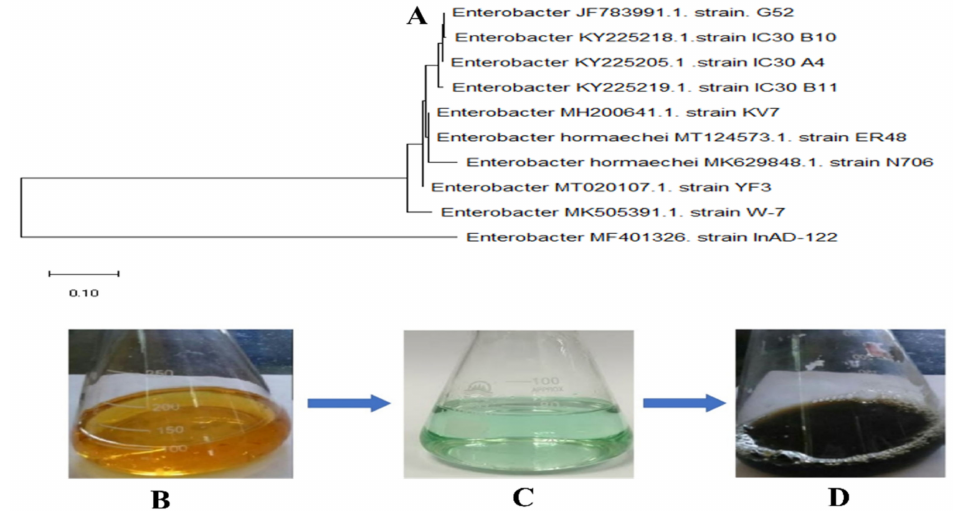
Figure 1. ( A ) Schematic study of the Enterobacter strain G52 16S rDNA sequence employed in the production of FeNPs; ( B ) the entire process of making FeNPs is depicted in this schematic picture, Enterobacter strain G52 filtrate; ( C ) Fe 2 SO 4 ·7H 2 O solution (13 mM); and ( D ) reduction and capping of Fe ions by Enterobacter strain G52 filtrate after 24